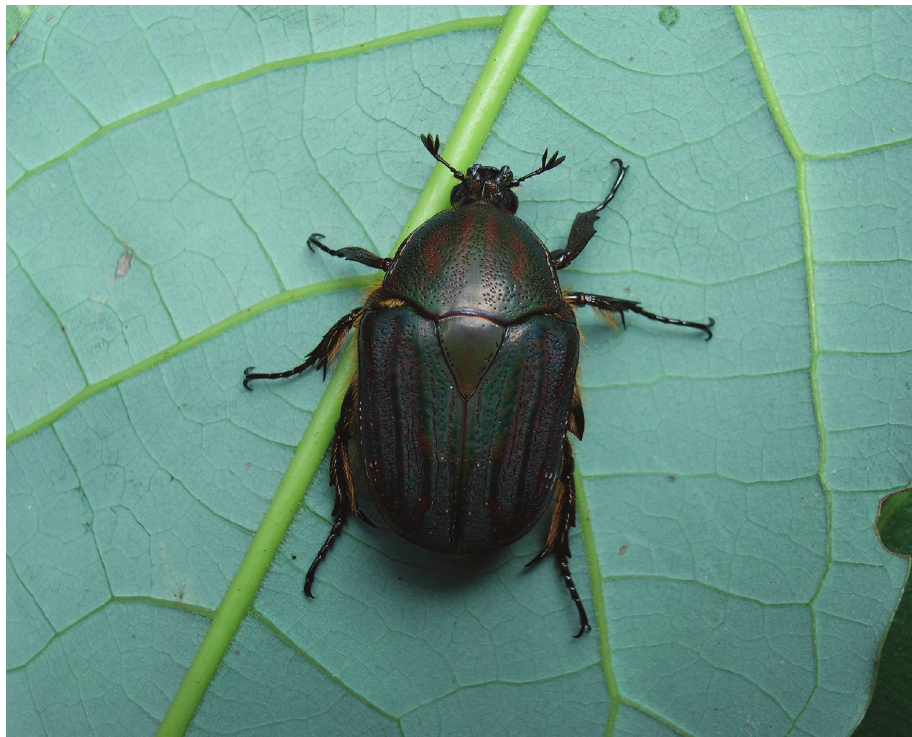
Figure 4. Lamellothyrea isimangaliso sp. n. in its natural habitat at St Lucia Estuary (Photo: Lynette Clen- nell, March